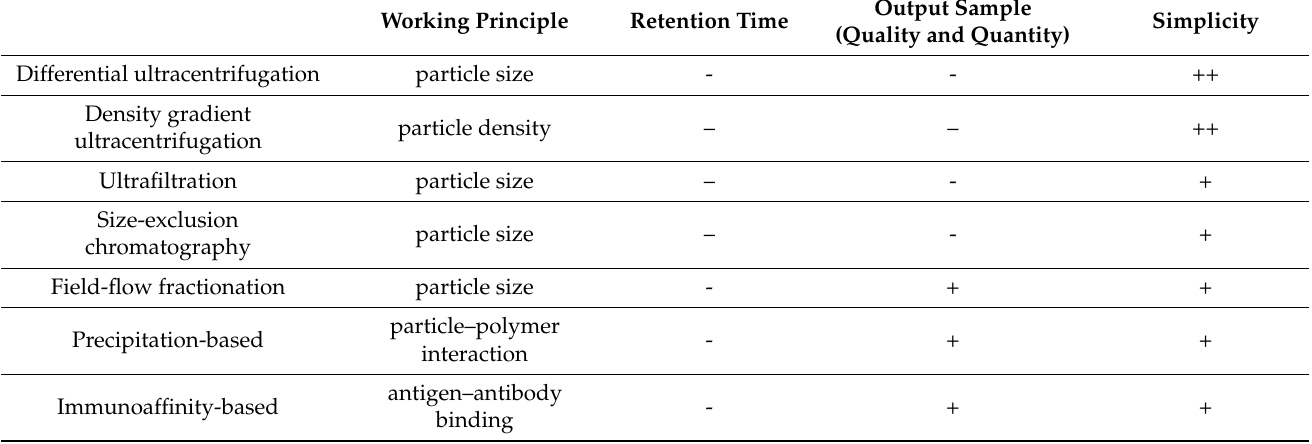
Table 1. Summary of the comparison of conventional techniques for EV isolation, based on different isolation strategies. Retention time, quality, and quantity of processed sample and protocol simplicity are evaluated according to the following scale: (–) difficult/very bad, (-) non-trivial/mediocre, (+) easy/good, (++) very